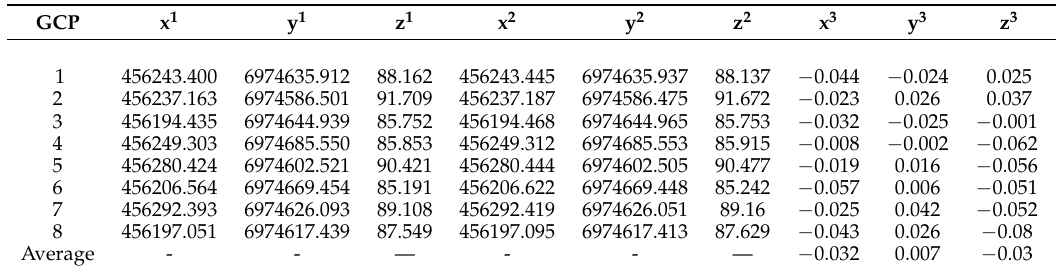
Table 5. Results of Propeller AeroPoint TM GCP comparison with terrestrial based survey (m).